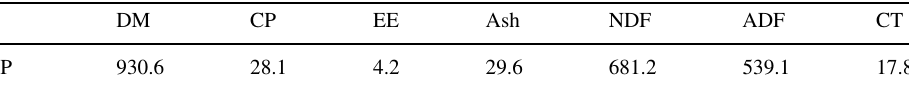
Table 4 Chemical